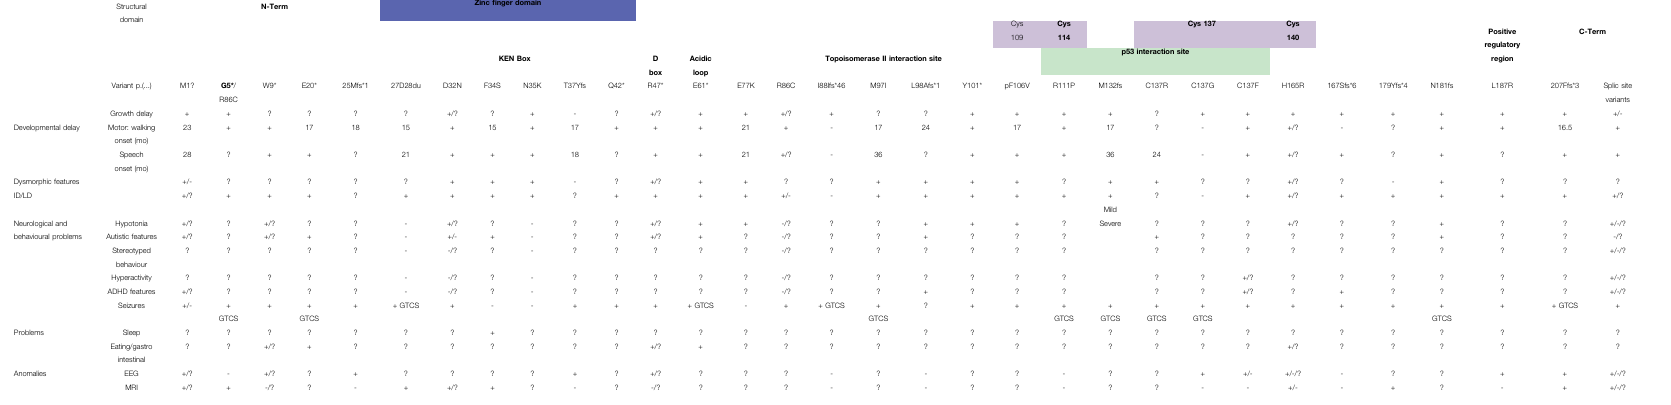
Acidic TopoisomeraseIIinteractionsite p53interactionsite loop